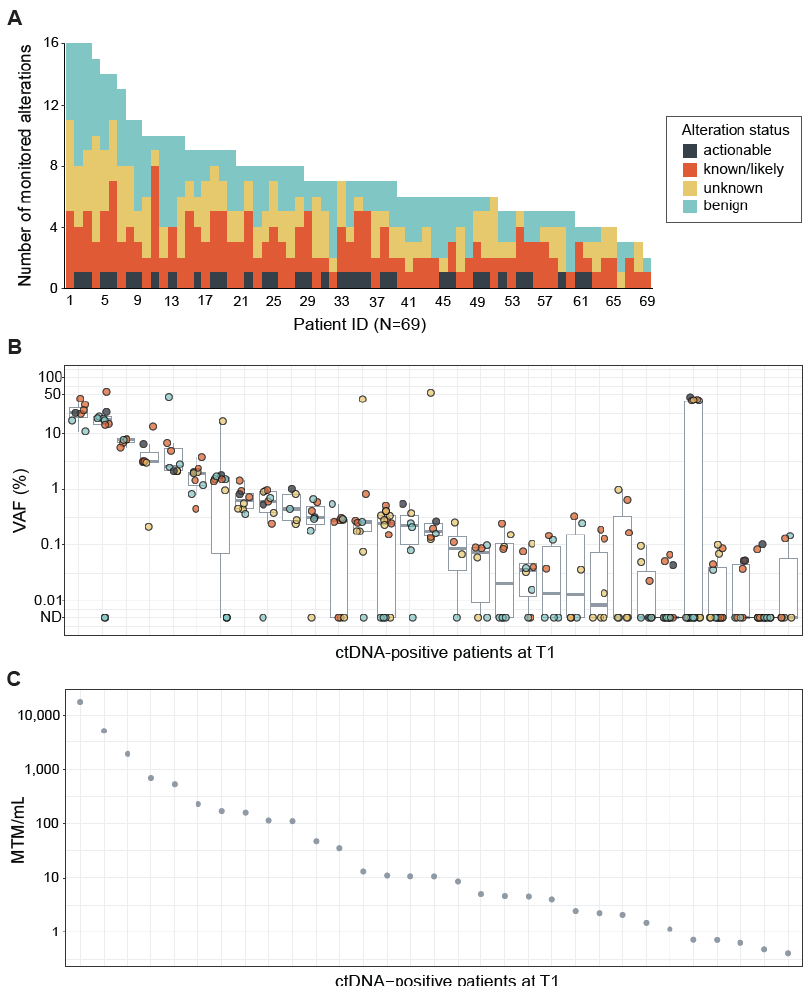
Figure 2. ( A ) Bar plot showing the variants designed for each sample and variant status. Actionable and known/likely are cancer-associated alterations. Benign alterations are intronic or synonymous alterations. Median monitorable alterations per sample = 7. ( B ) Variant Allele Frequency (VAF) of each monitored alteration in ctDNA-positive samples at the postsurgical time point (T1). Boxplot indicates the distribution of VAF values. Average VAF of all detected alterations = 6.0%, range = 0.014 to 56.5%. Alteration status is represented by color. ( C ) Assessment of MTM/mL for each ctDNA-positive patient. ND = Not detected, unknown = variants of unknown significance.